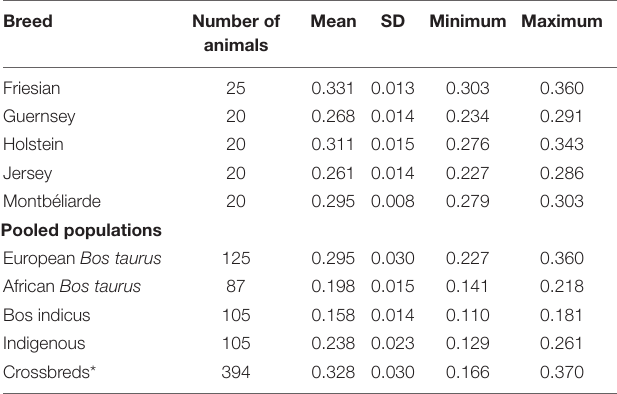
TABLE 3 | Average heterozygosities of reference and West African crossbred populations. Breed Number of